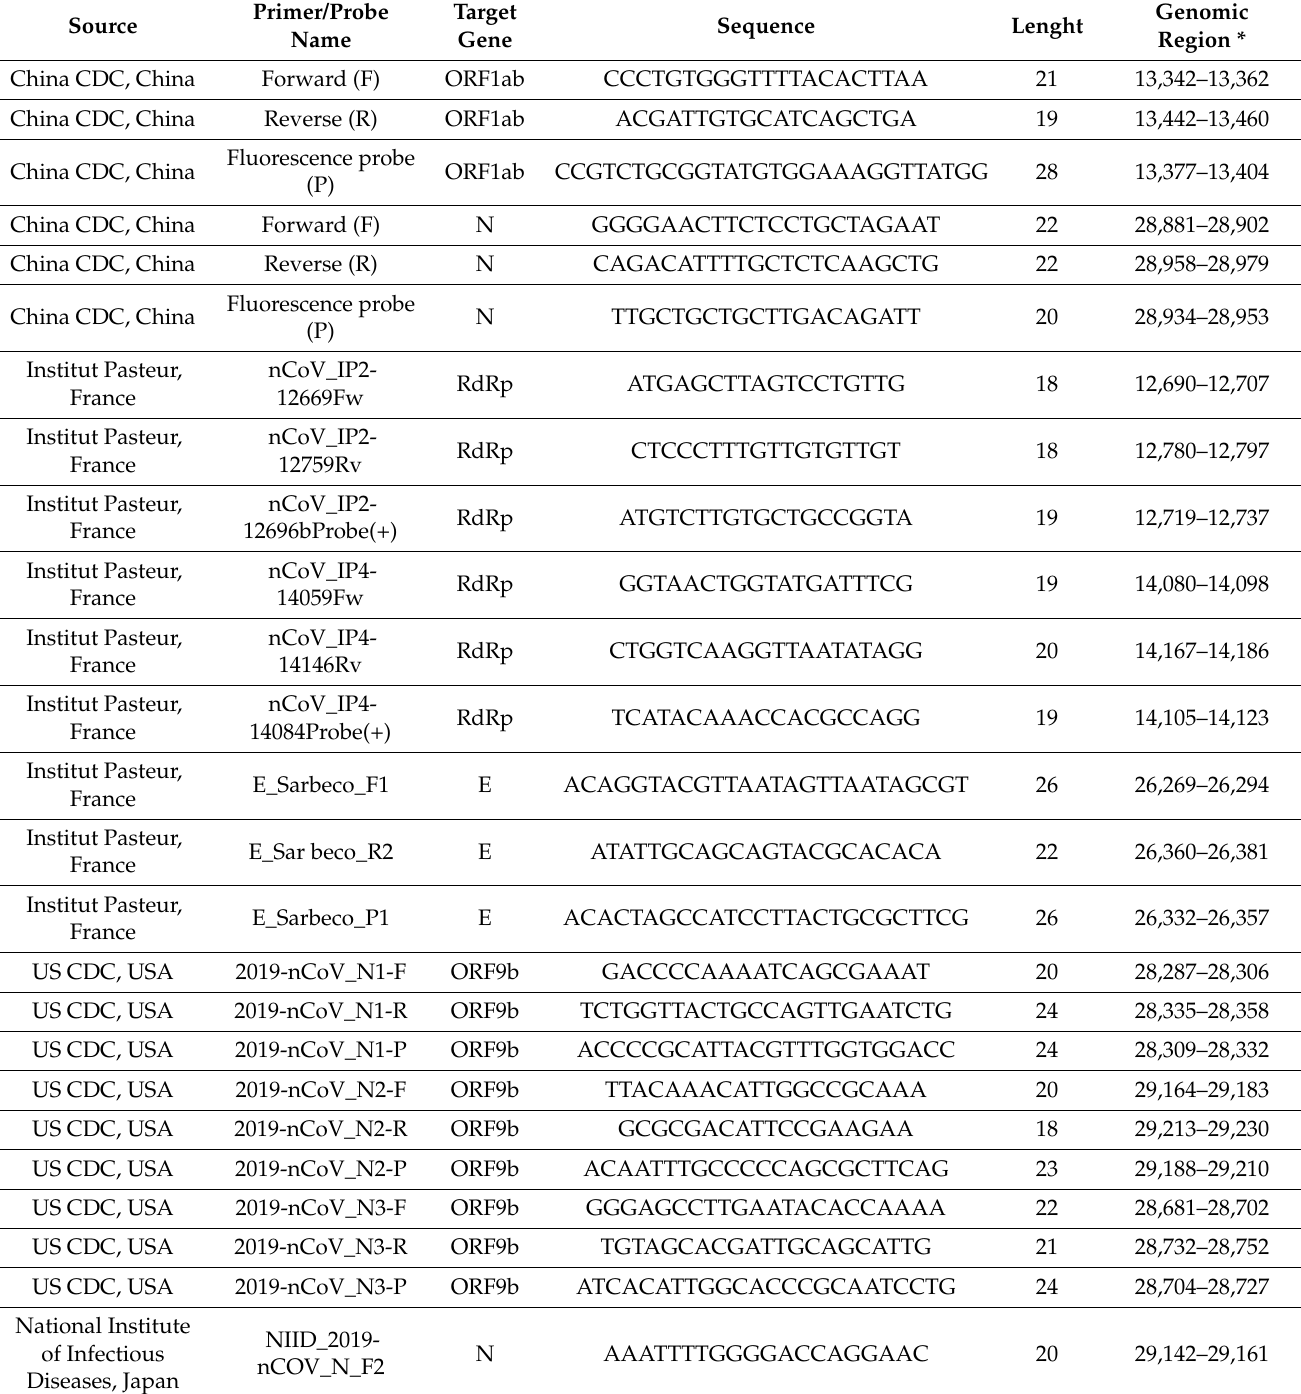
Table 2. Summary of primers/probes sets released by WHO for in-house reverse transcription polymerase chain reaction (RT-PCR) detection of